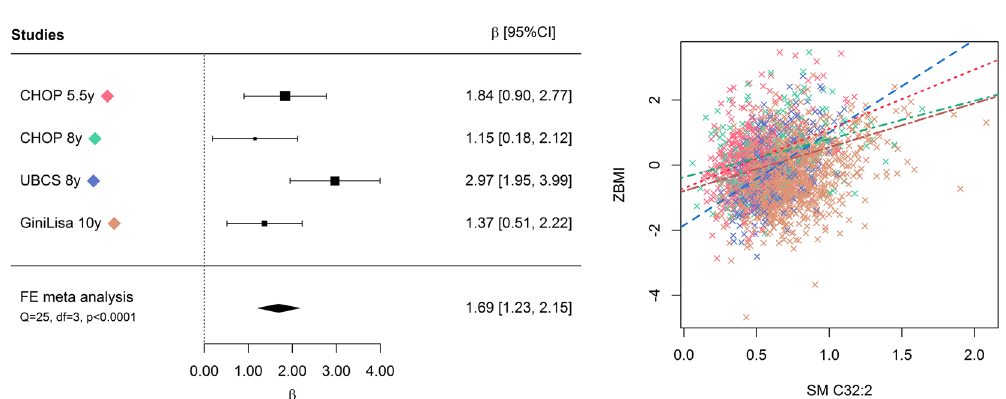
Figure 2. Forest plot and scatterplot on the association of SM 32:2 with BMI z-score. The forest plot (left) shows the study-specific regression estimates (and 95% confidence intervals [95%CI] corrected for multiple testing) of the age and sex adjusted regression models quantifying the effect of an increase of 1 µ M in SM 32:2 on BMI z-score. The regression estimate and 95%CI for the individual fixed-effects (FE) participant data meta-analysis adjusted for sex is shown as a diamond. Heterogeneity of study estimates was assessed using Cochran’s Q-test. The scatterplot (right) shows the results of study-specific bivariate